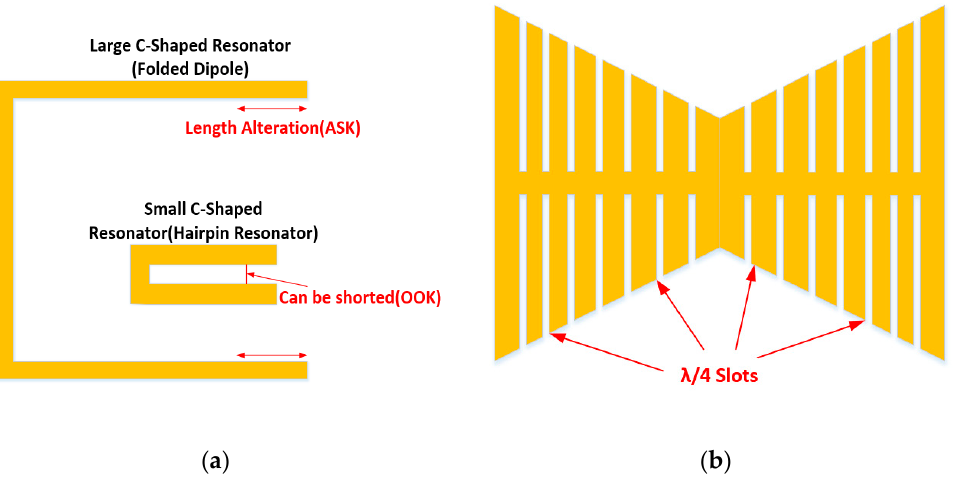
Figure 6. C-Shaped Resonators ( a )—Adapted from References [93,95]. Slotted Bow Tie Resonator ( b )—Adapted from Reference [98].